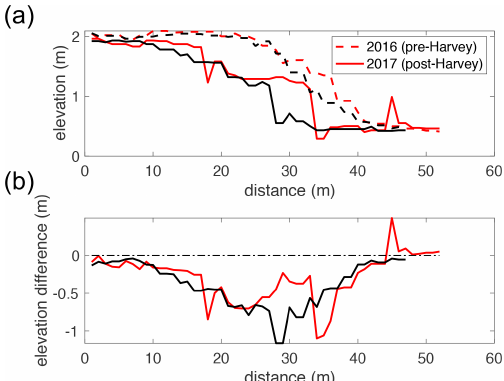
Figure 10. (a) Transects of beach before (dashed lines) and after (solid lines) Hurricane Harvey. (b) Difference between 2016 and 2017 transects. See Fig. 8 for locations of transects at Site